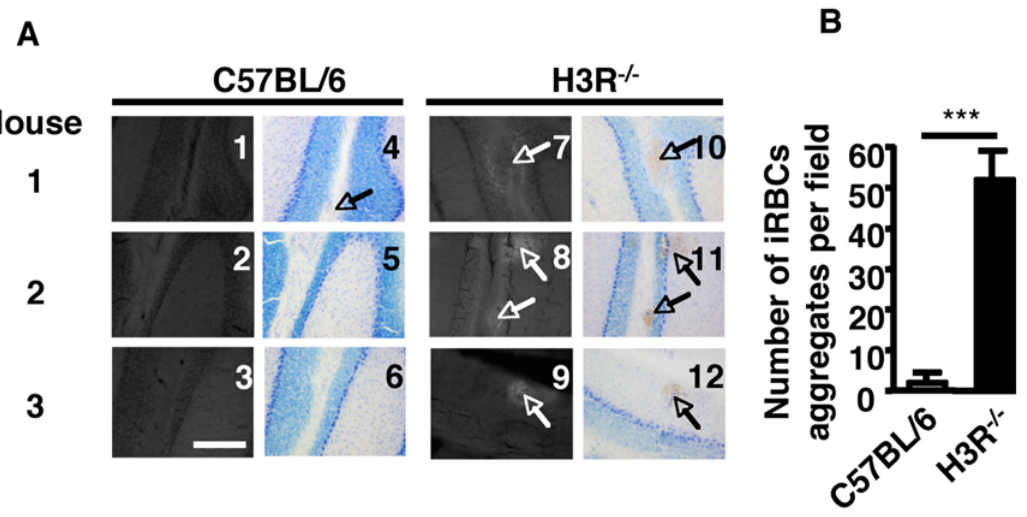
Figure 3. Formation of hemorrhagic lesions occurs earlier in the brain of H3R 2 / 2 mice. Wild-type C57BL/6 mice and H3R 2 / 2 mice (3 mice per group) were inoculated intraperitoneally with 10 6 Pb ANKA-infected erythrocytes per mouse. At day 5 post-infection, mice were perfused with PBS then PFA 4% and brain sections were made. (A) Brains Sections stained with May-Gru¨nwald Giemsa. Blood-stage parasites associated with sequestered erythrocytes (panels 10, 11, and 12) in the brain could be visualized by fluorescence (panels, 7, 8, and 9) because of their expression of GFP only in H3R 2 / 2 mice (white shadow indicated by arrows). At this time, no deposition of fluorescent parasites could be observed in brain sections from uninfected (not shown) and only scarce number of aggregates could be detected in infected C57BL/6 mice (arrow in panel 4 for mouse 1). Data are representative of three mice per group. (B), The density of erythrocyte aggregates in brain sections of infected H3R 2 / 2 and C57BL/6 mice were expressed as the average of aggregates in three sections and counted in 250 consecutive microscopic fields per section at magnification 250 6 . These data are from two different experiments. *** Significant difference was obtained between infected H3R 2 / 2 and C57BL/6 mice using Mann-Whitney test (p=0.0003). Bar, 100 m m.